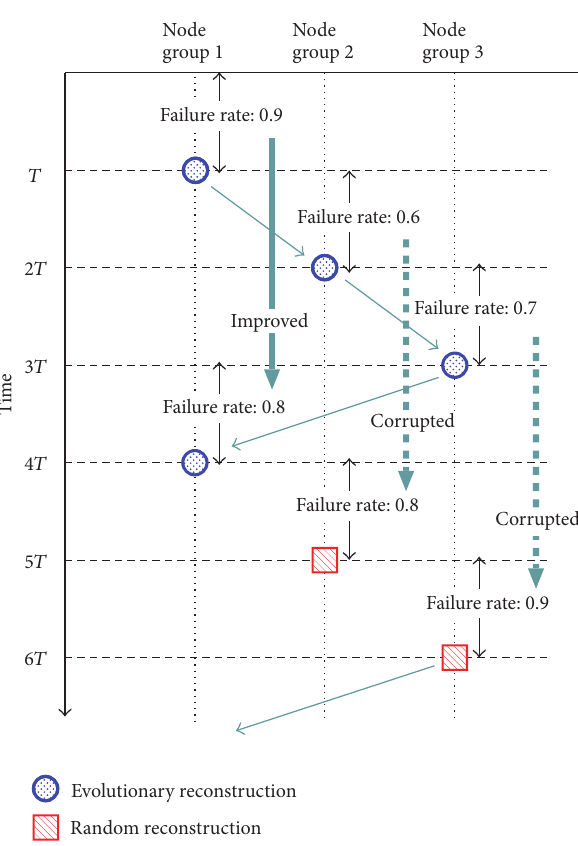
Figure 10: The proposed adaptive strategy for network topology